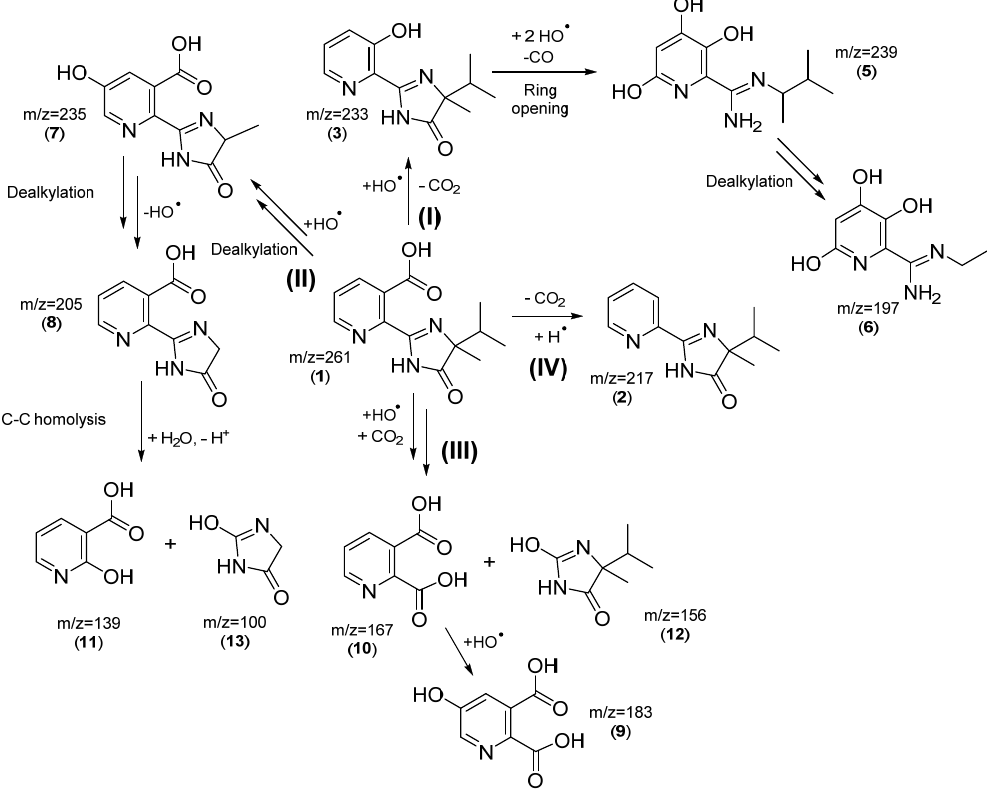
Figure 18. Proposed degradation pathways for Imazapyr.